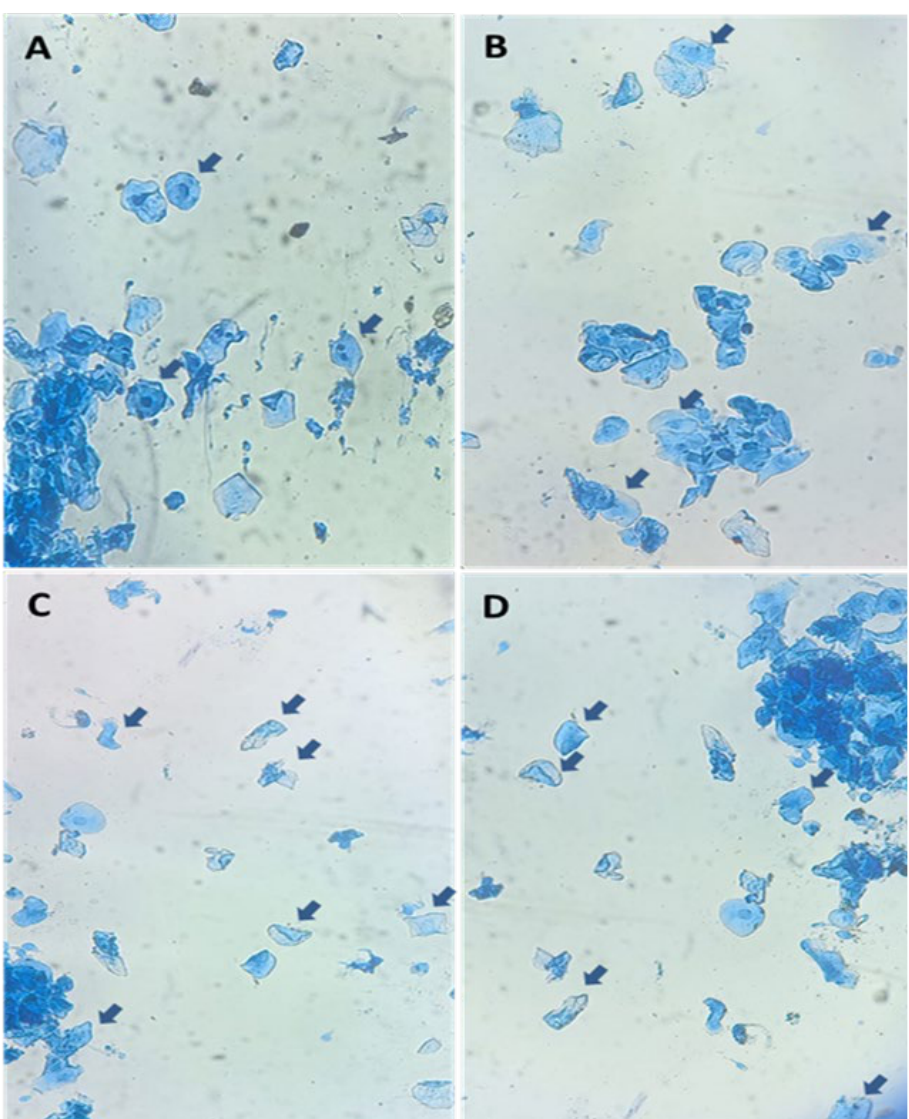
Figure 2. Representative cytological images (Diff–Quick staining) obtained from the dorsal area of the middle third of the vagina by using swabs in llamas ( Lama glama ): ( A ) presence of parabasal cells (arrows), ( B ) presence of intermediate cells (arrows), ( C , D ) presence of superficial/cornified cells (arrows).